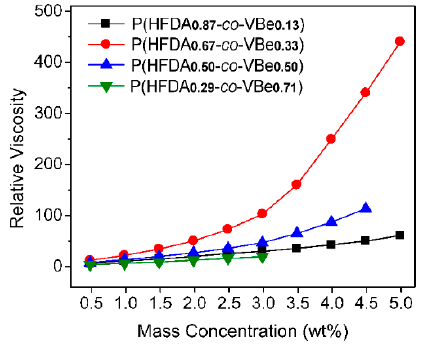
Figure 6. Relative viscosities of the co-polymer–CO 2 systems at 308.2 K and 30 MPa versus mass concentration.